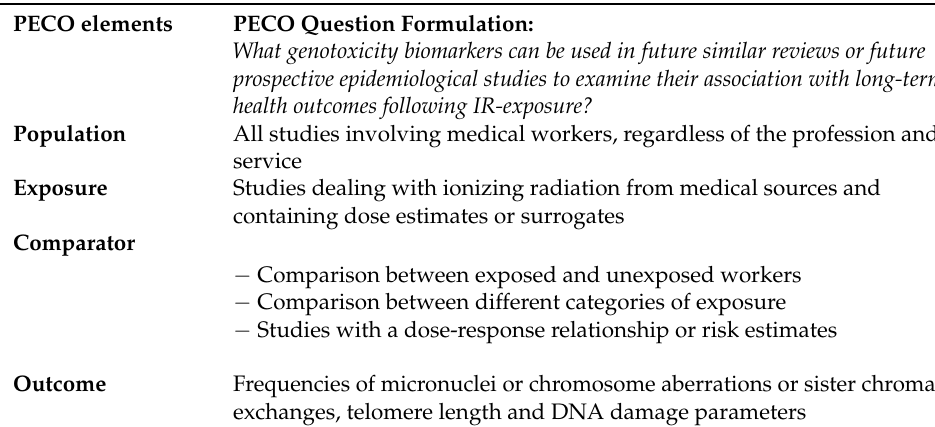
Table 1. Selection criteria (PECO